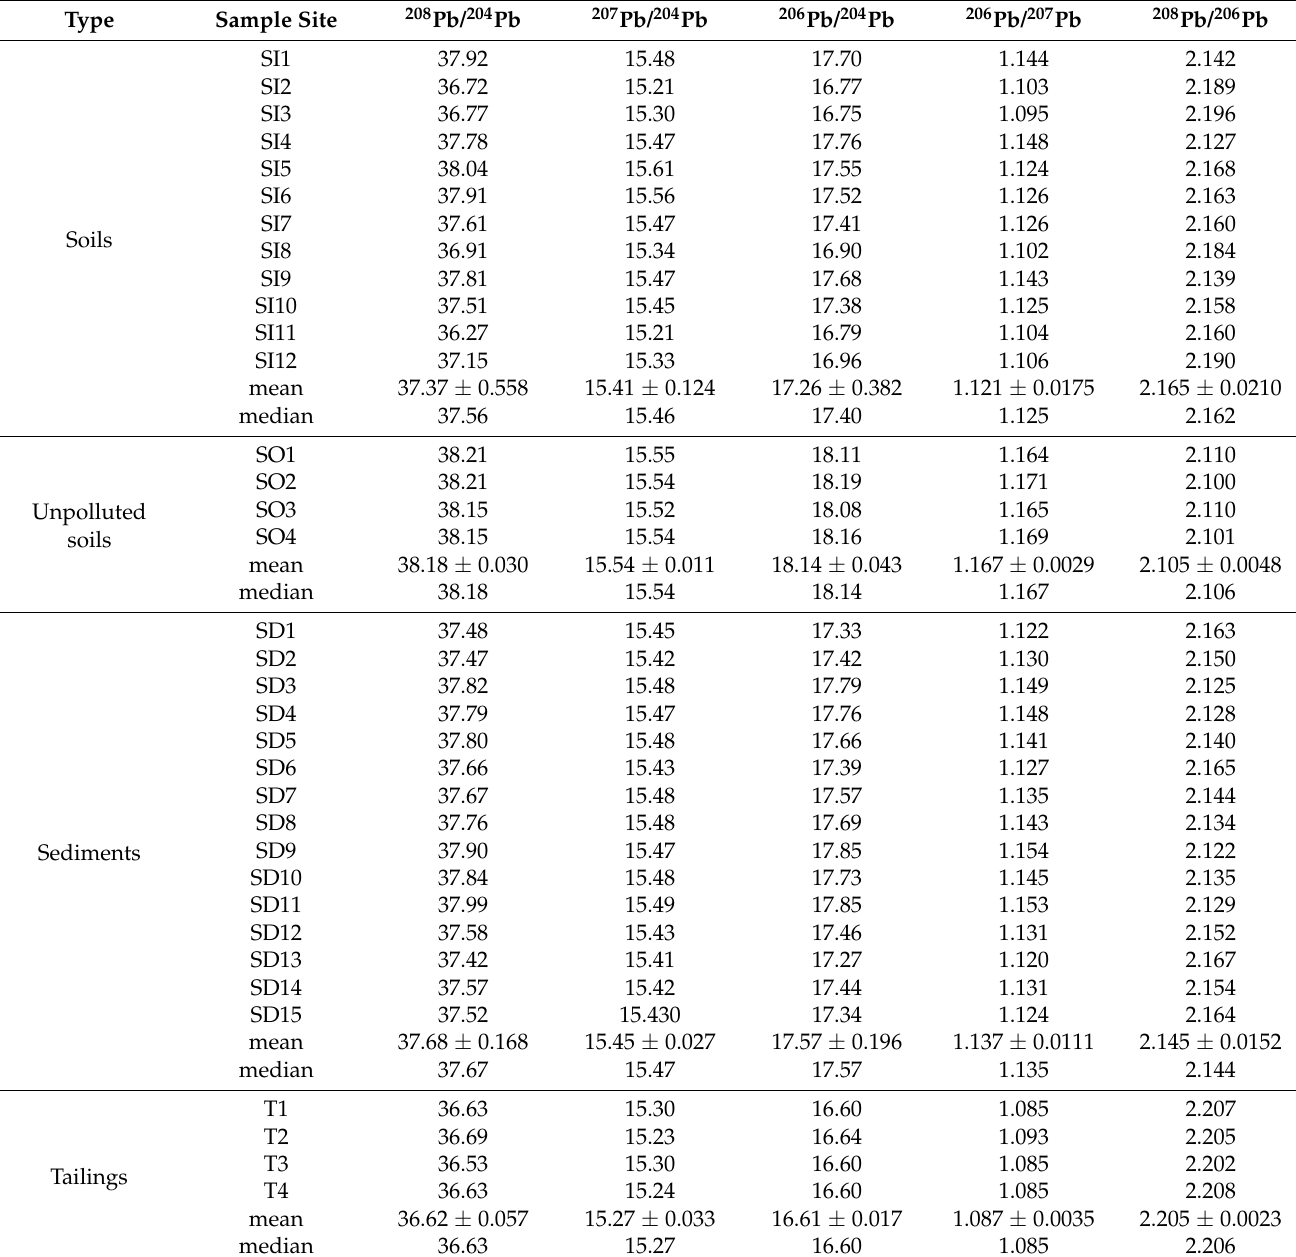
Table 4. Pb isotopic component in soils and